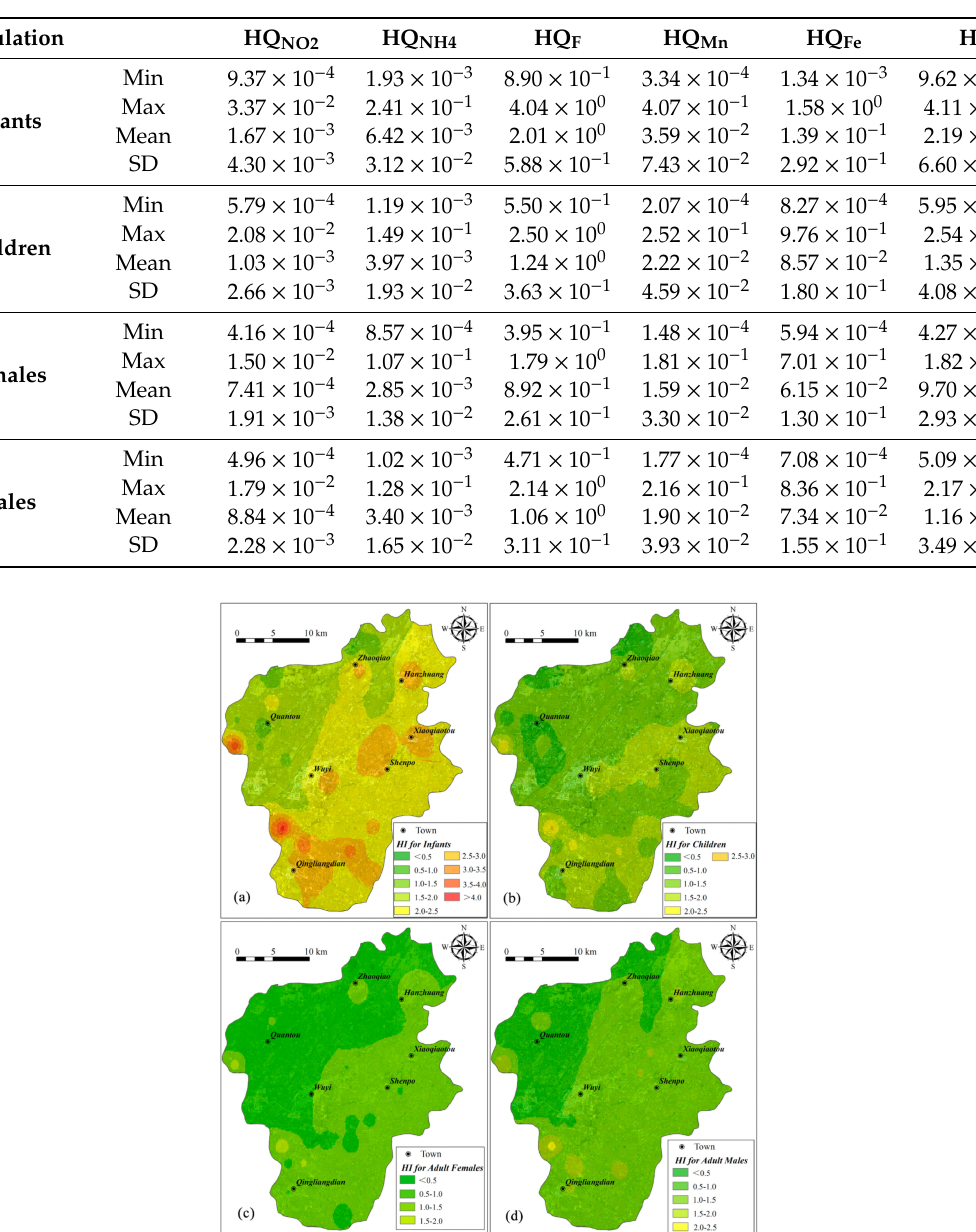
Table 4. Statistics of health risks assessment results through drinking water intake.